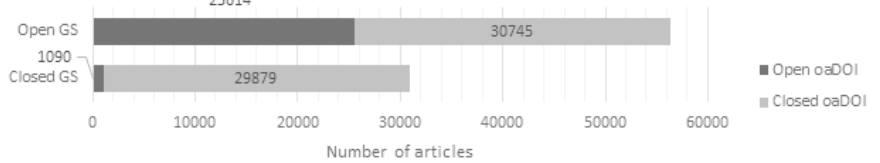
Figure 2. Open articles according to oaDOI’s Best_location, 2011–2016. The bar “All years *” reflects the total number of self-archived articles otherwise classified under Open Toll or Open Journal.